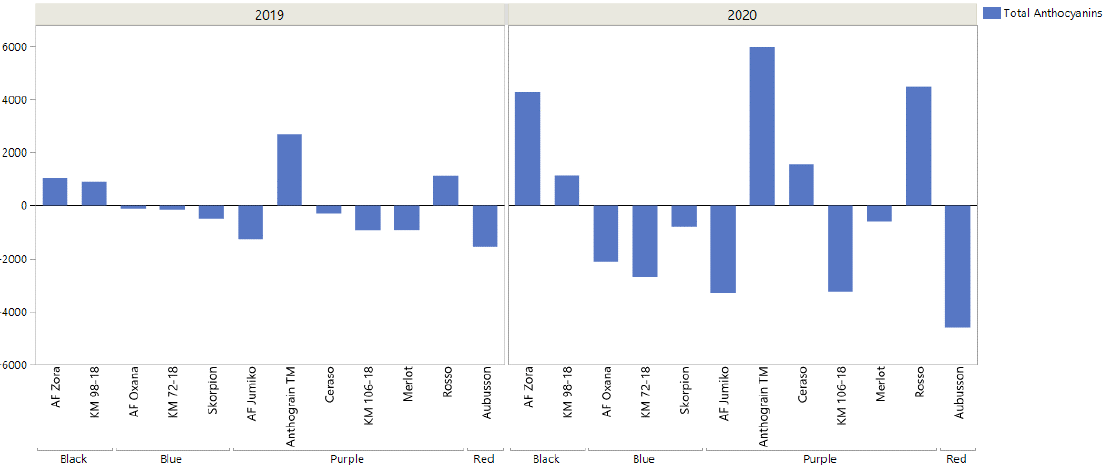
Figure 1. Deviation from the mean value calculated for total anthocyanins (expressed as the sum of all the metabolites detected within this study) for each variety and for each harvest year. Overall, the pattern obtained was in accordance with previous reports, as purple- grained wheats were richer in peonidin and had limited content in petunidin, while malvidin glucoside was absent. Its presence was consistent in both blue and black ones, which were the sole varieties containing delphinidin glycosides [16]. Blue-grained wheats instead had higher amounts of cyanidin, malvidin, and petunidin, while red va- rieties were reported in the literature as the less rich in total anthocyanins and devoid of pelargonidin derivatives